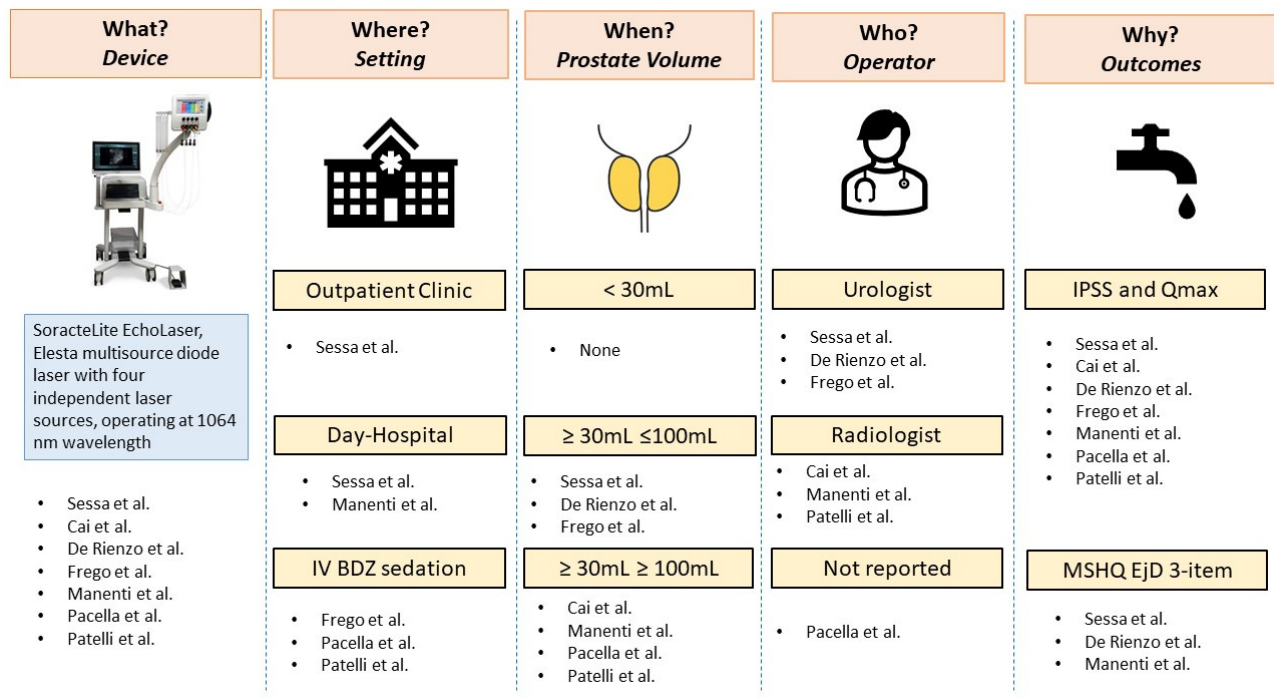
Figure 1. The five Ws of TPLA. IV BDZ: intravenous benzodiazepine; IPSS: International Prostate Symptom Score; Qmax: maximum flow rate; MSHQ EjD: Male Sexual Health Questionnaire Ejaculation Disfunction [12–18]